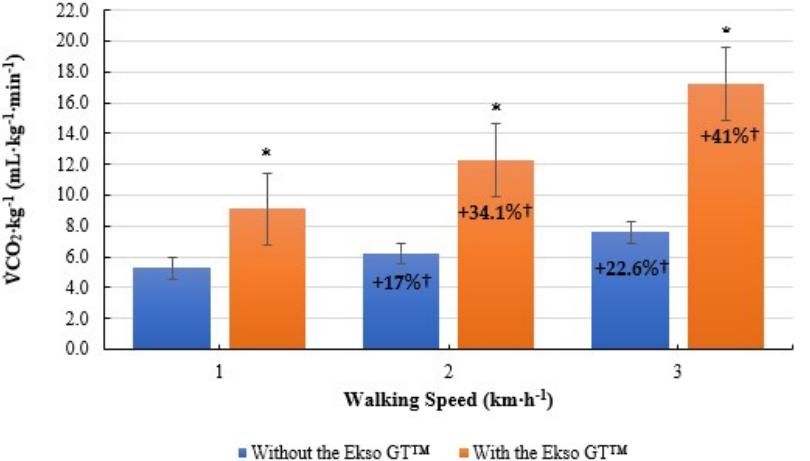
. VCO 2 · kg − 1 ; mL · kg − 1 · min − 1 )